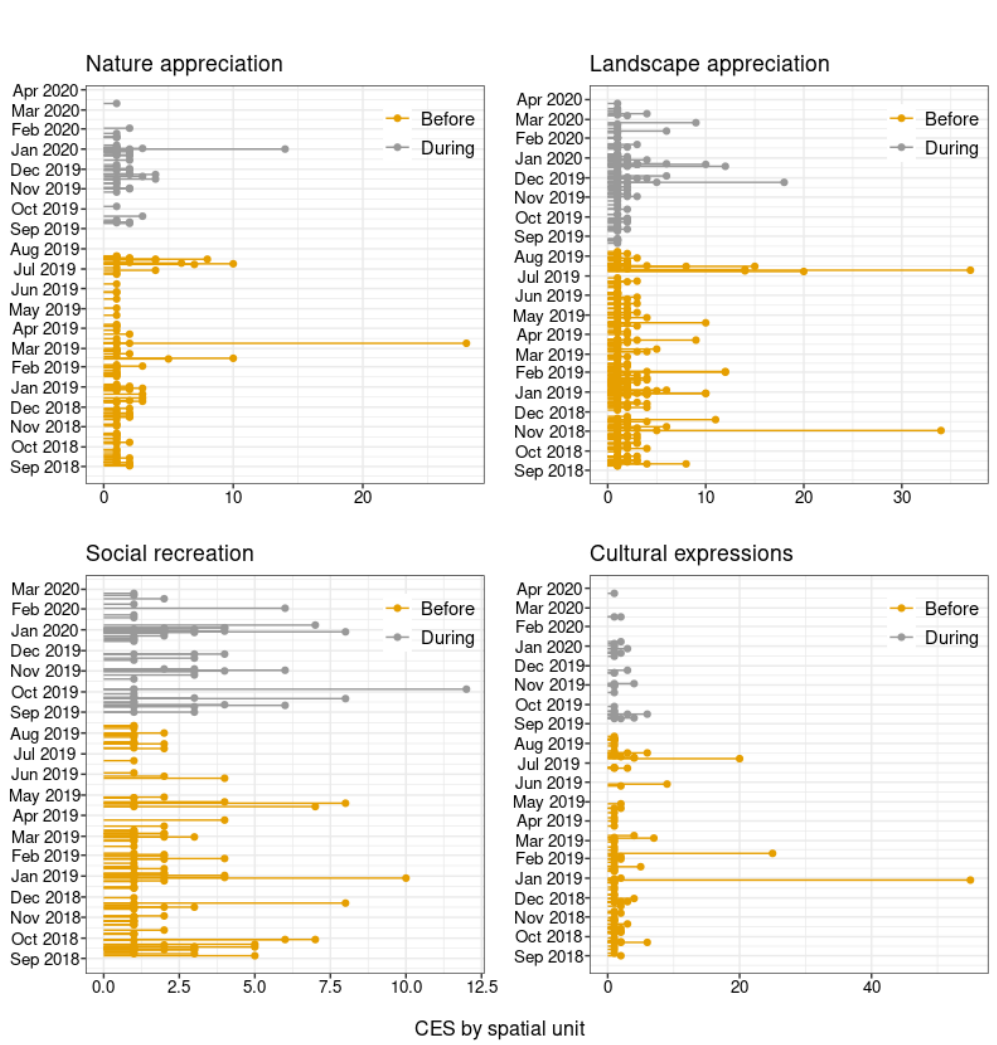
Figure 3. Temporal representation of Cultural Ecosystem Services by spatial unit along the Brazilian coast, before and during the oil spill.